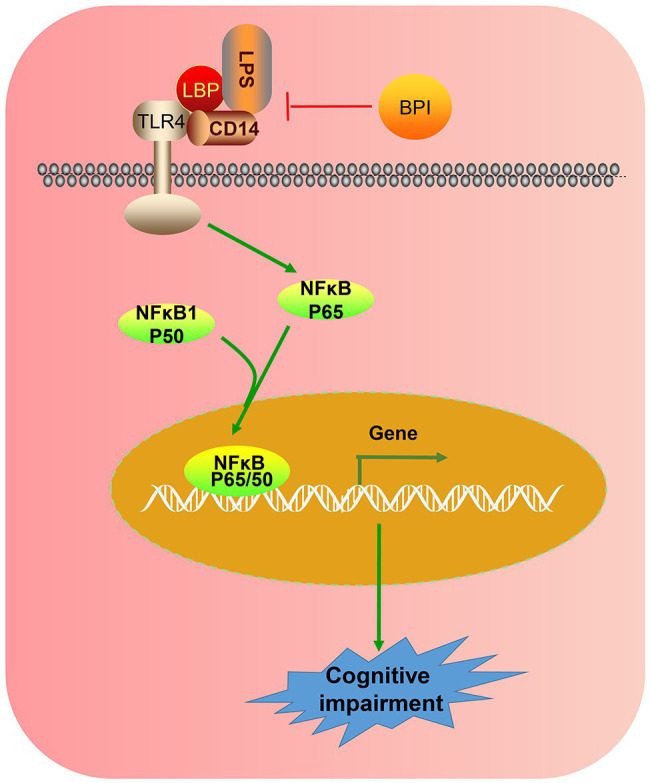
Diagram depicting a potential mechanism of interactions. BPI can alleviate cognitive impairment in diabetic mice by blocking the LPS-LBP-TLR4 signaling pathway. LPS was overexpressed and BPI was poorly expressed in diabetic mice with cognitive impairment. Exogenous LPS promotes inflammation, insulin resistance, and cognitive impairment in diabetic mice. Overexpression of BPI inhibited the LPS-LBP-TLR4 signaling pathway, thereby suppressing the NF-κB signaling pathway and ultimately reducing inflammation, insulin resistance, and cognitive impairment in diabetic mice.